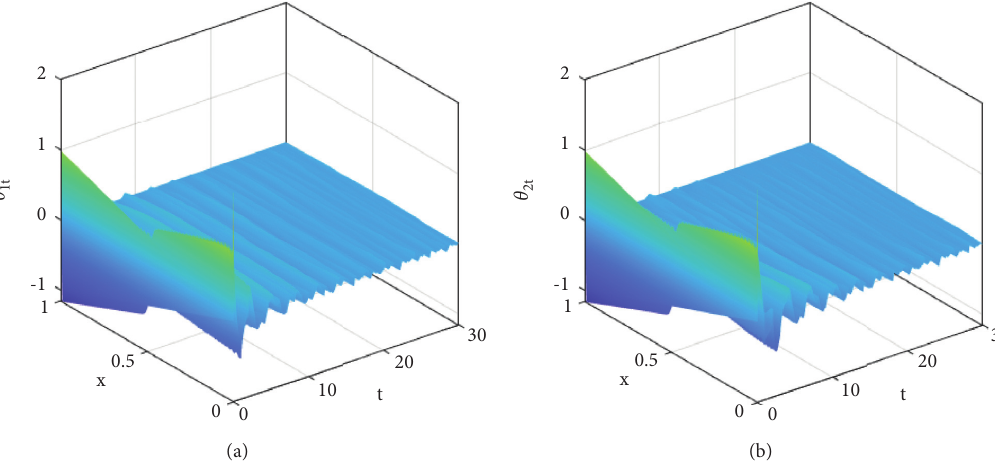
Figure 3: (a) The velocity of θ